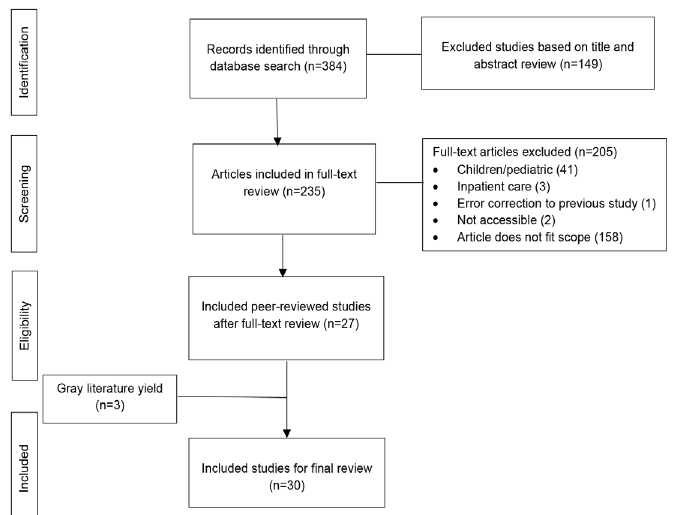
Figure 1. Flow diagram of review of discharge risk-stratification